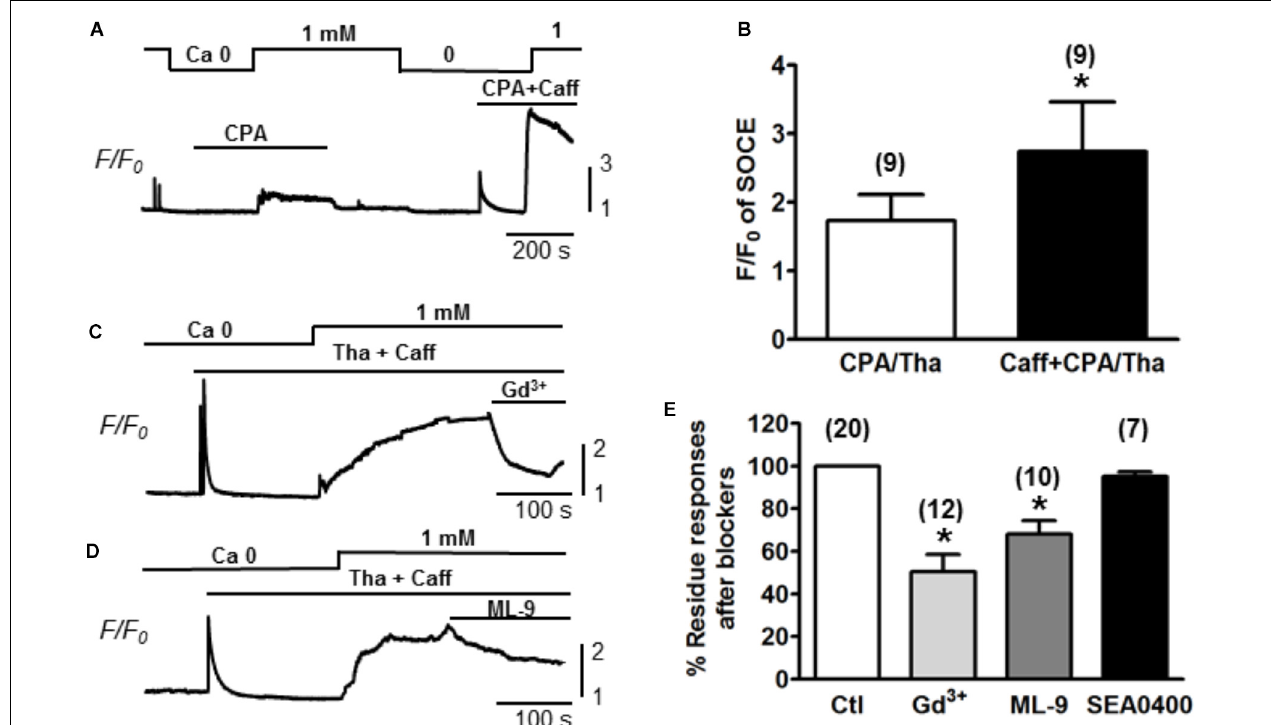
FIGURE 1 | Store-operated Ca 2 + entry measured in adult mouse ventricular myocytes. (A) A representative recording of SOCE from an adult mouse ventricular myocyte. Ca 2 + fluorescence intensity ( F/F 0 ) in normal Tyrode’s solution (1 mM Ca 2 + ) and Ca 2 + -free (Ca 2 + ) Tyrode’s solution was measured. SOCE was detected under partial SR Ca depletion by 10 µ M CPA (an inhibitor of SERCA) alone or complete depletion by 10 µ M CPA and 10 mM caffeine (CPA + Caff). (B) Summary of F/F 0 responses (SOCE) recorded in the presence of 10 µ M CPA or 1 µ M thapsigargin (Tha, another SERCA blocker) (CPA/Tha) alone (1.7 ± 0.4) or together with caffeine (2.7 ± 0.7, ∗ p < 0.05), suggesting the complete depletion of SR Ca is required for maximal SOCE activation. (C,D) Representative traces of SOCE and its inhibition by TRPC or SOCE blockers (i.e., Gd 3 + and ML-9). (E) Summary data demonstrating the putative SOCE was inhibited by SOCE/TRPC channel blockers (39.8 ± 4.5% inhibition by 1 mM Gd 3 + and 31.8 ± 6.3% inhibition by 10 µ M ML-9. ∗ p < 0.05 compared to control, Student’s t -Test) but not SEA0400 (4.9 ±